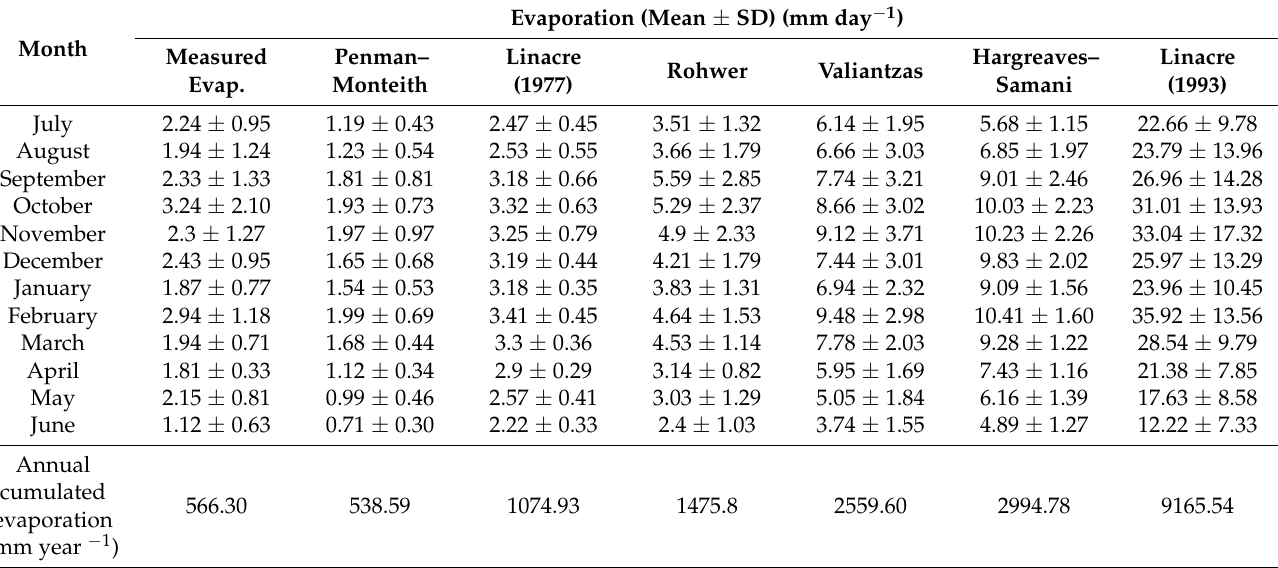
Table 2. Comparative table showing the mean and standard deviation for six evaporation methods and measured evaporation.